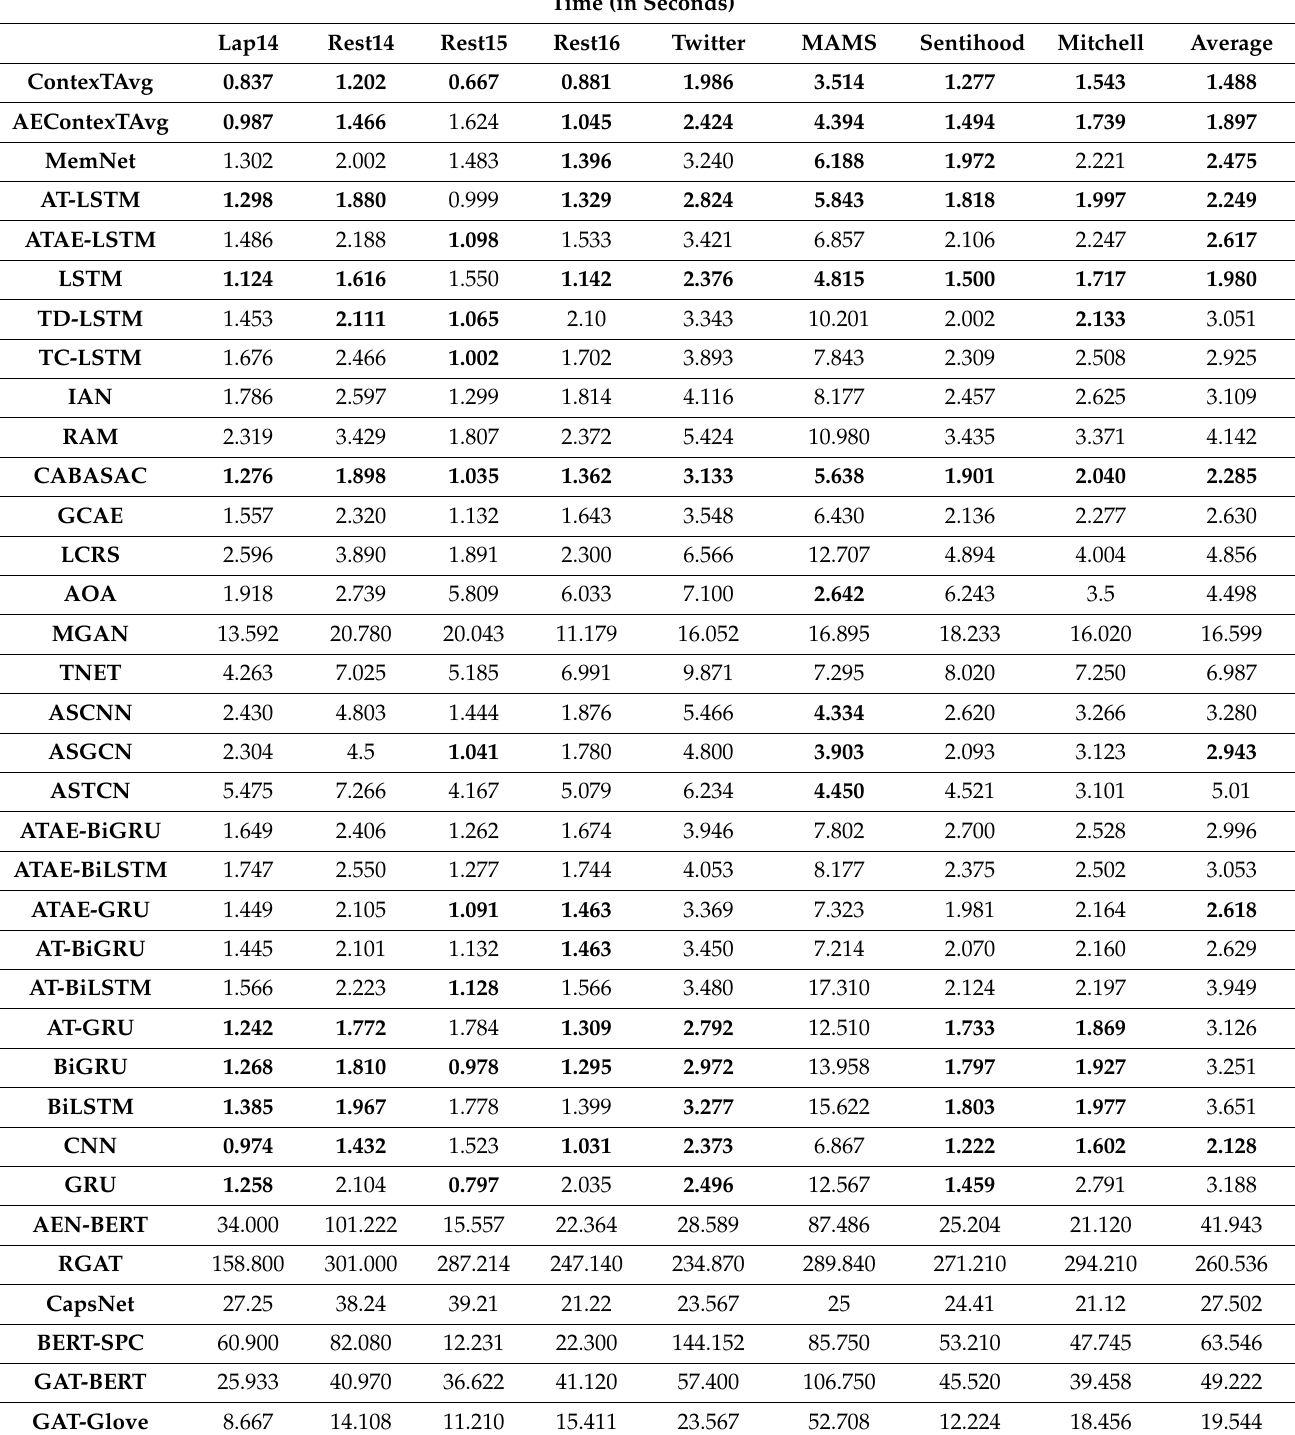
Table 5. Experimental results for Time taken in our